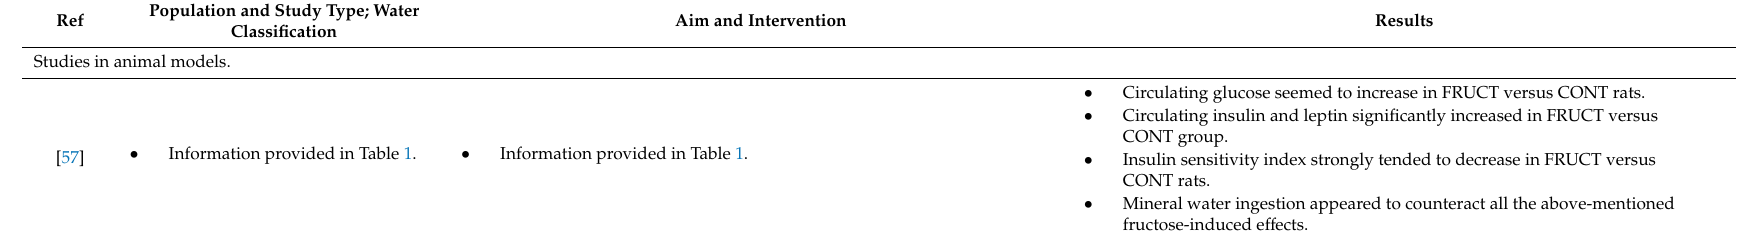
Table 3. The influence of mineral water consumption upon